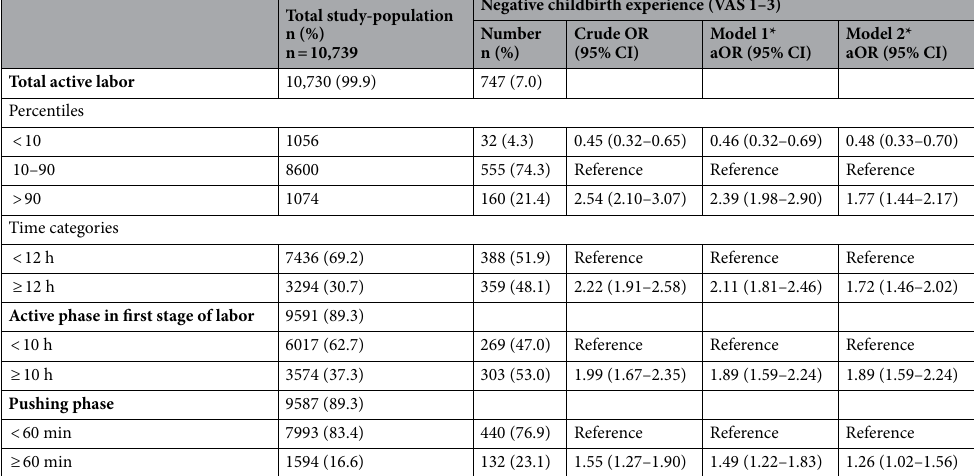
Table 3. Time in labor and risk of negative childbirth experience (VAS 1–3) in primiparous women. VAS visual analogue scale, h hours, min minutes, OR odds ratio, CI confidence interval. *Adjustments in. Model 1: maternal age, BMI and fetal birthweight. Model 2: maternal age, BMI, fetal birthweight, start of labor (spontaneous vs induction) and mode of delivery (vaginal birth vs cesarean section).